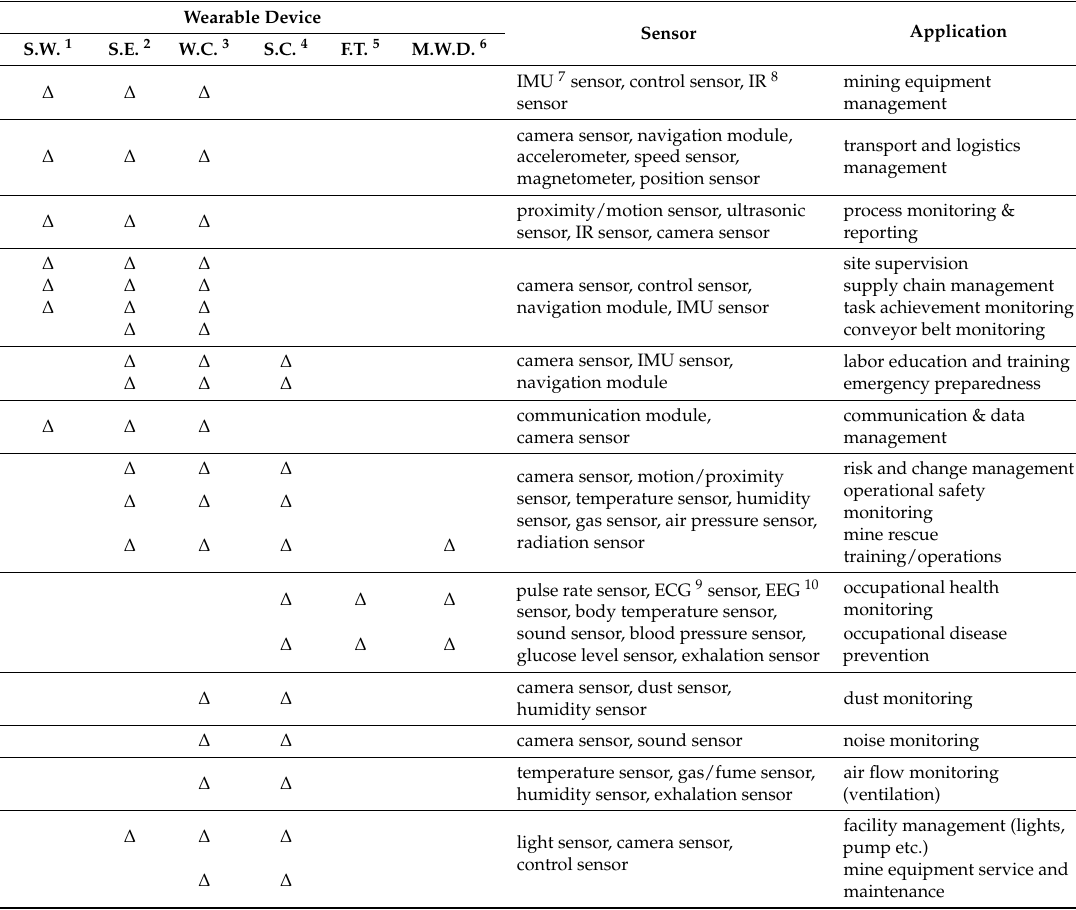
Table 2. Possible applications of wearable devices and sensors in the mining